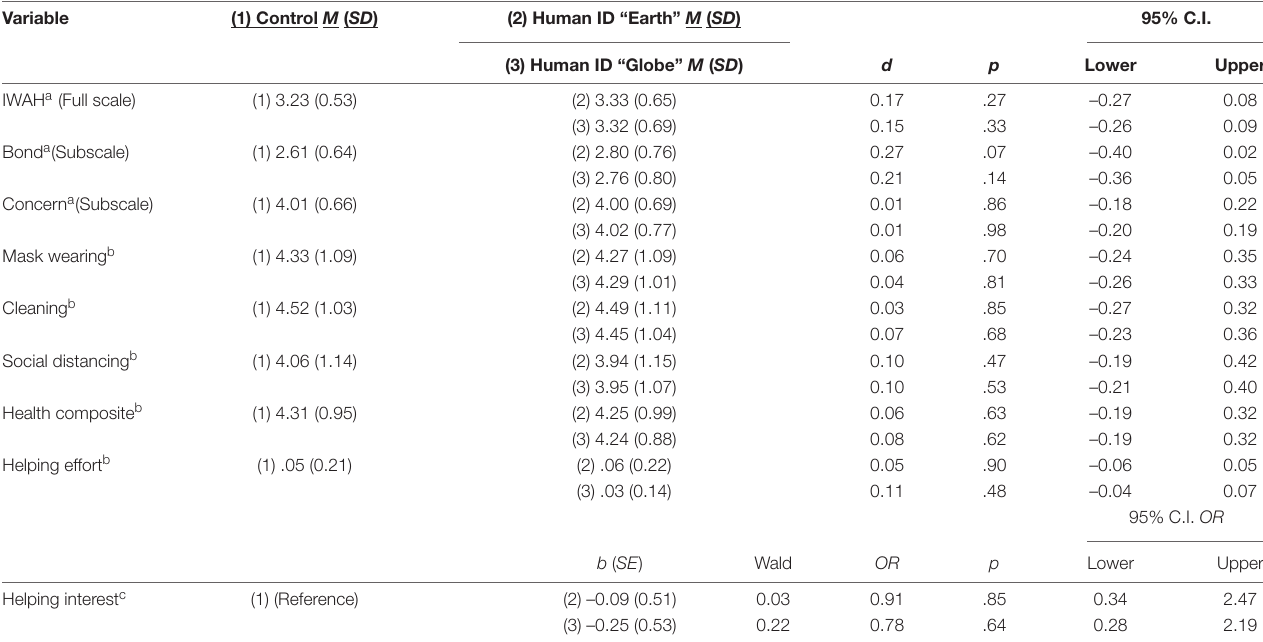
TABLE 2 | Descriptive statistics and pairwise comparison results of ANOVAs, ANCOVAs, and binary logistic regression in Study 1.